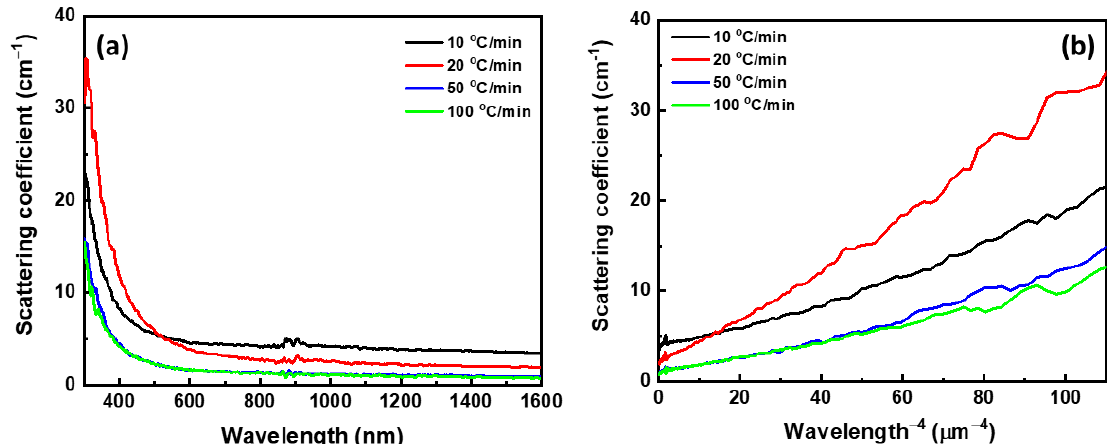
Figure 9. ( a ). The scattering coefficients γ sca as a function of λ and ( b ) the dependence of scattering coefficient on the wavelength to the minus fifth power ( λ − 4 ) for the Y 2 O 3 with various heating rates.